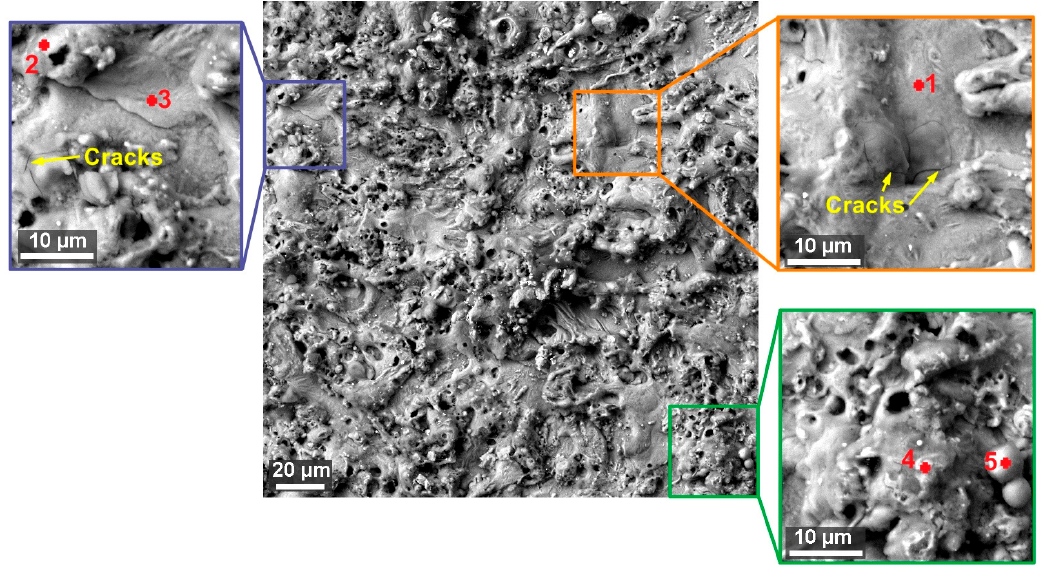
Figure 6. Surface morphology of Sample 20 (machined by setting machine parameters: U = 70 V, T on = 6 µ s, T = 50 µ s, v = 14 m / min, and I = 25) made of 1Fe alloy (SEM / backscattered electron (BSE)) o ff Table 6. Analysis of chemical composition in individual places according to Figure 6 in wt. %.